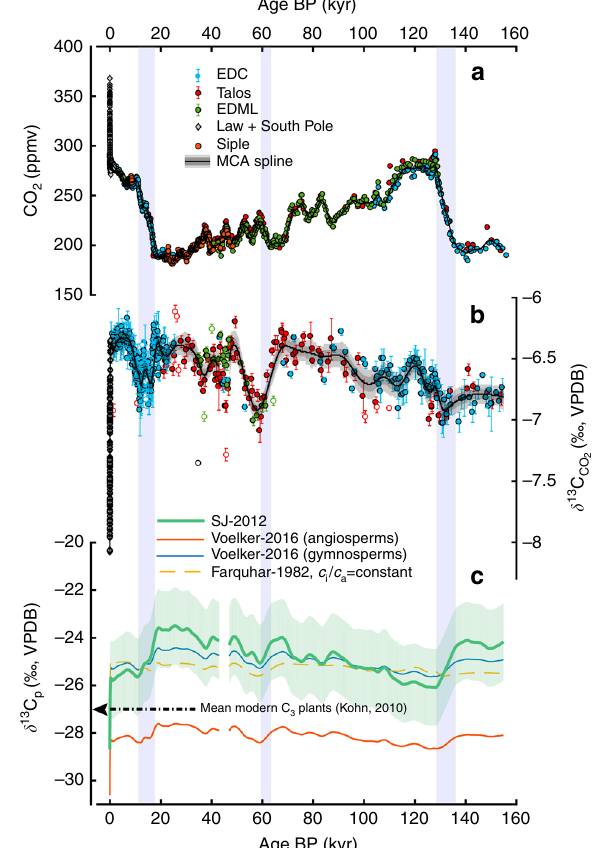
Fig. 1 Ice core records of stable carbon isotope composition and concentration of CO 2 from 155 kyr BP to the present. a CO 2 concentration data from the preindustrial era compiled from EPICA Dome C (EDC), Talos Dome, EPICA Dronning Maud Land (EDML), and Siple ice cores, with post- industrial records from Law Dome and South Pole. Black curve shows a Monte Carlo average (MCA) spline. b Corresponding δ 13 C CO MCA spline. Error bars are 1 σ uncertainties. Dark grey region is 1 σ con fi dence interval for spline. Open circles indicate outliers identi fi ed by ref. 33 . c Models of δ 13 C p calculated from ice core records. SJ-2012 model (light green curve) is shown with 1 σ propagated uncertainties. Blue bars indicate three periods where this model predicts a change in δ 13 C p of more than 1 ‰ at a rate exceeding 0.25 ‰ /kyr, excluding the period of recent anthropogenic